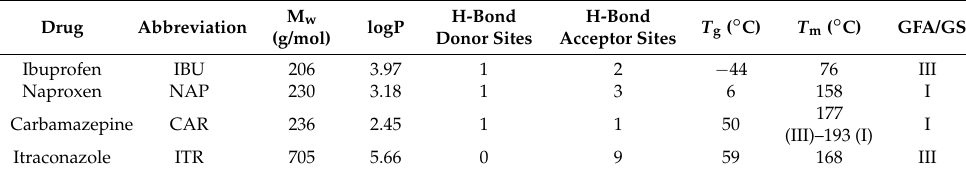
Table 1. Physico-chemical properties of ibuprofen, naproxen, carbamazepine, and itraconazole. GFA: